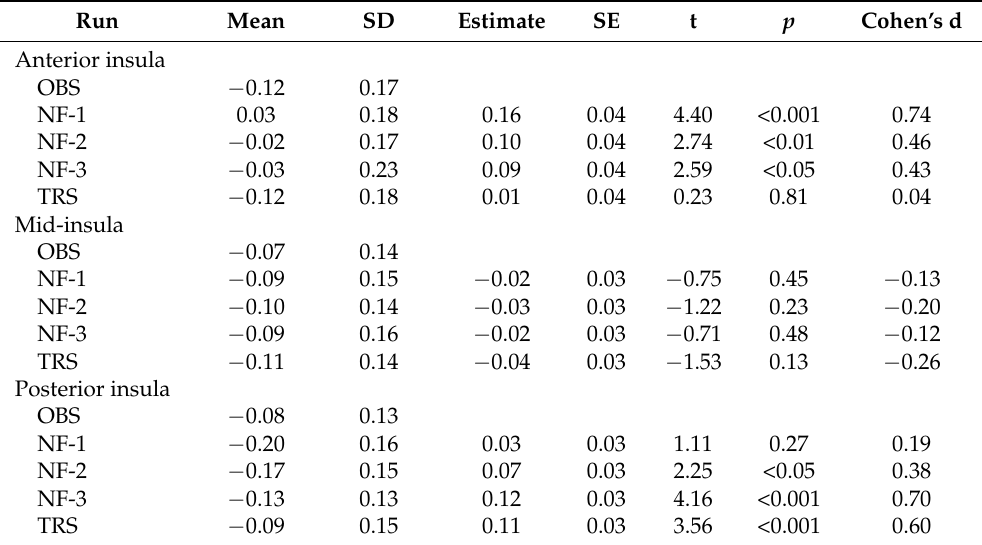
Table A3. Unadjusted means, standard deviations, effect sizes, and main analyses of parameter estimate (Focus-on-Breath vs. Rest) in insula subregions across runs.